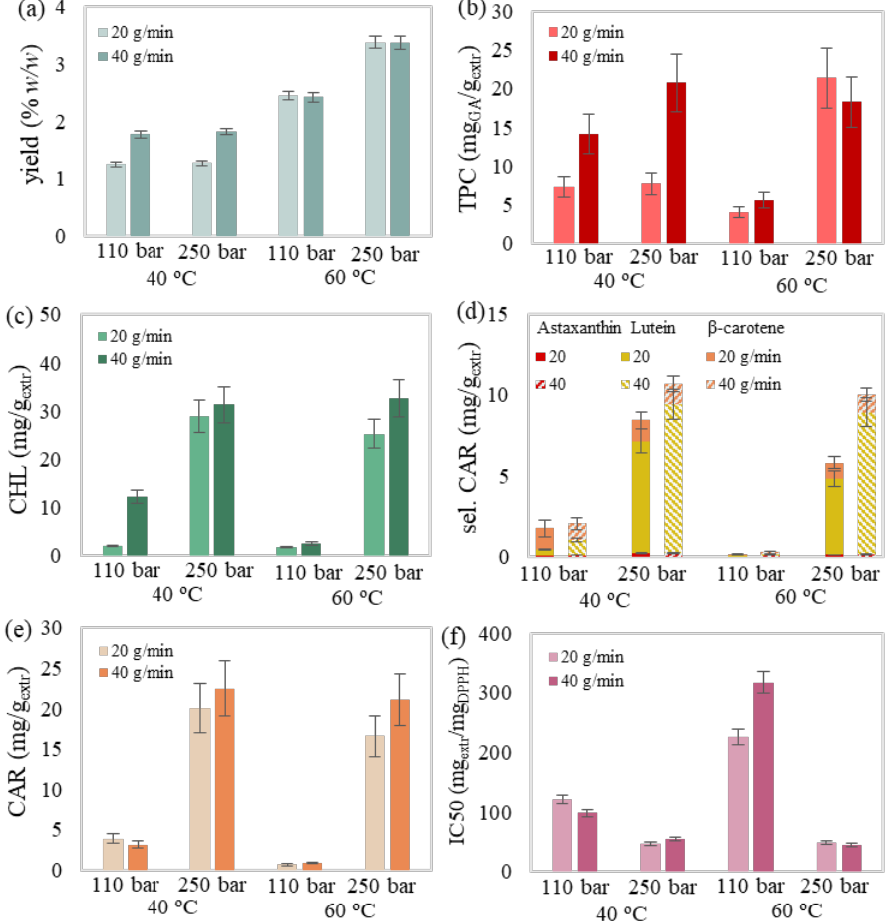
Figure 4. Simultaneous effect of temperature, pressure and flow rate on SFE’s ( a ) yield, ( b ) total phenolic, ( c ) chlorophyll, ( d ) selected carotenoid, ( e ) total carotenoid content and ( f ) antioxidant activity. The presented error bars express the standard deviation percentage of the central point replicates.